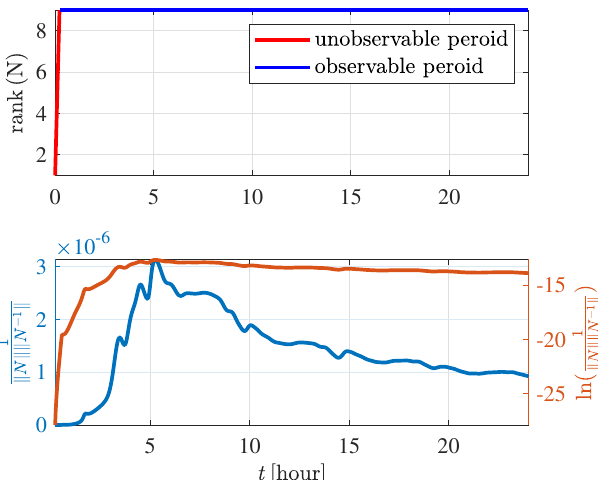
Figure 2. Observability analysis results of the zeroth-order polynomial.